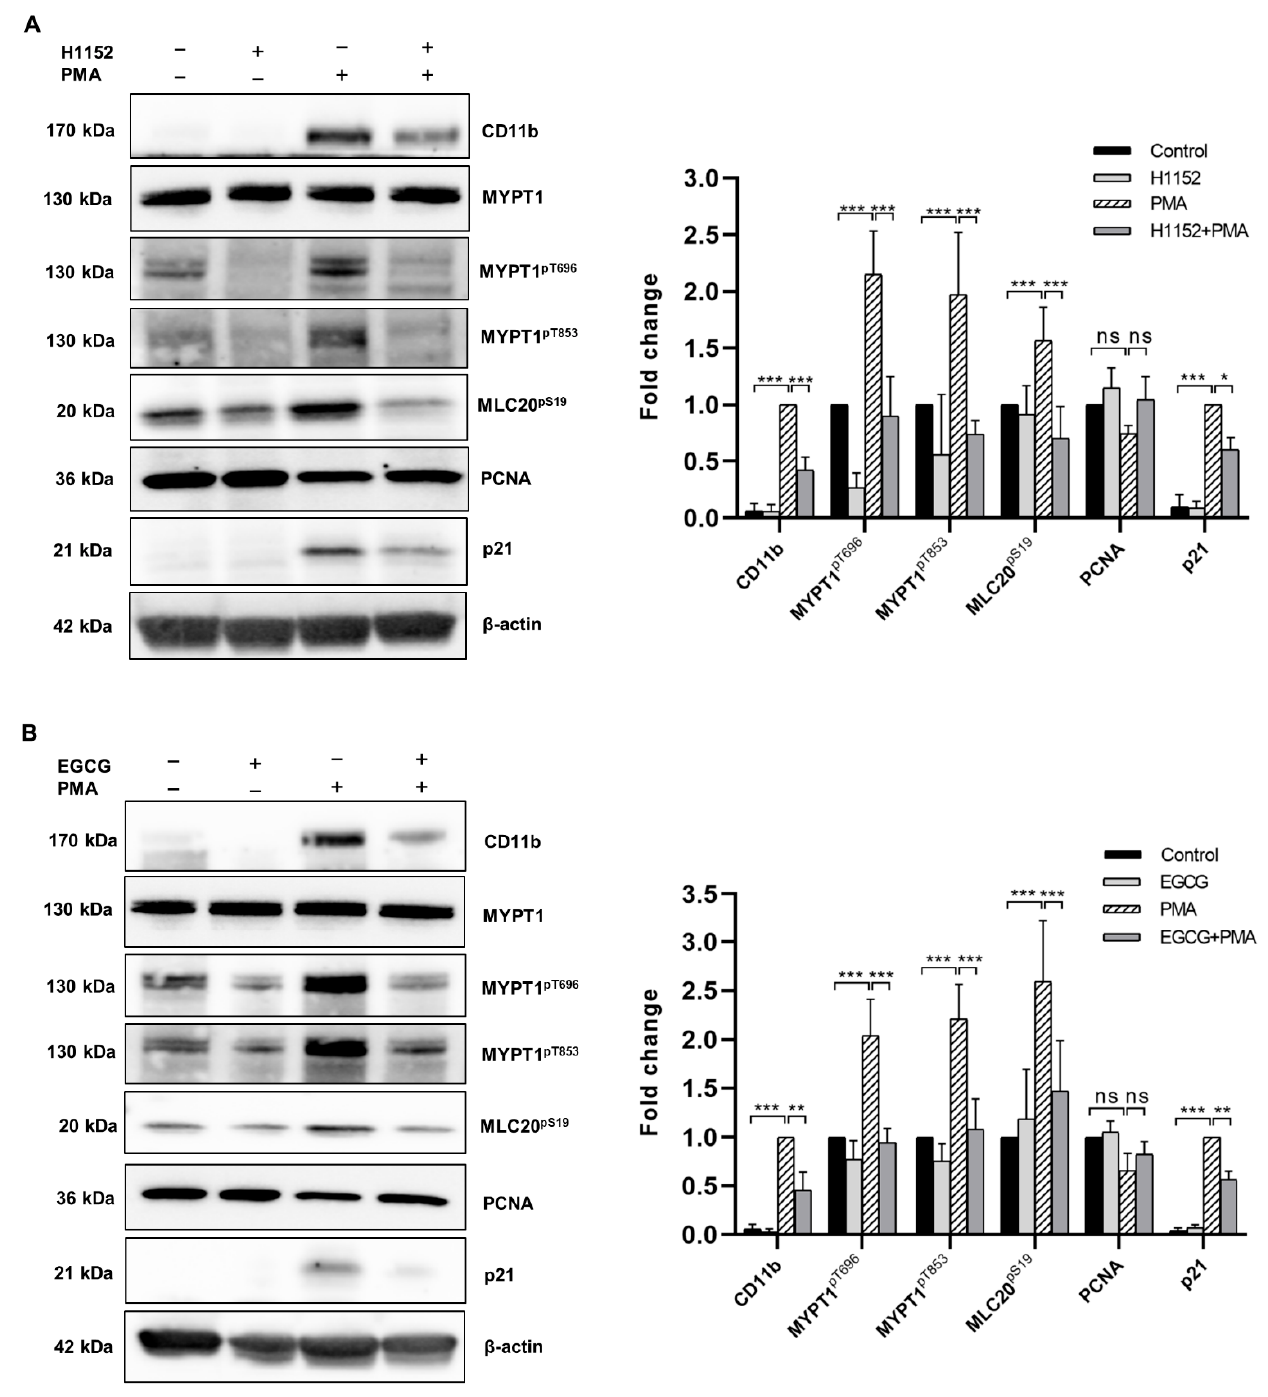
Figure 3. H1152 and EGCG activate myosin phosphatase and attenuate PMA ‐ induced macrophage differentiation. THP ‐ 1 cells were pretreated with 10 μ M H1152 for 30 min ( A ) or 20 μ M EGCG for 1 h ( B ), then treated with PMA for 48 h. Expressions of CD11b, MYPT1 pT696 , MYPT1 pT853 , MLC20 pS19 , PCNA, and p21 were analyzed by Western blotting. The total MYPT1 and β‐ actin were used as loading controls. Histograms demonstrate fold changes of protein or phosphorylation levels relative to unstimulated cells (for MYPT pT696 , MYPT pT853 , MLC20 pS19 , and PCNA) or PMA ‐ stimulated cells (for CD11b and p21). Data were analyzed by two ‐ way ANOVA, followed by Tukey’s multiple comparisons ( n = 5, * p < 0.05, ** p < 0.01, *** p < 0.001, ns: not significant).